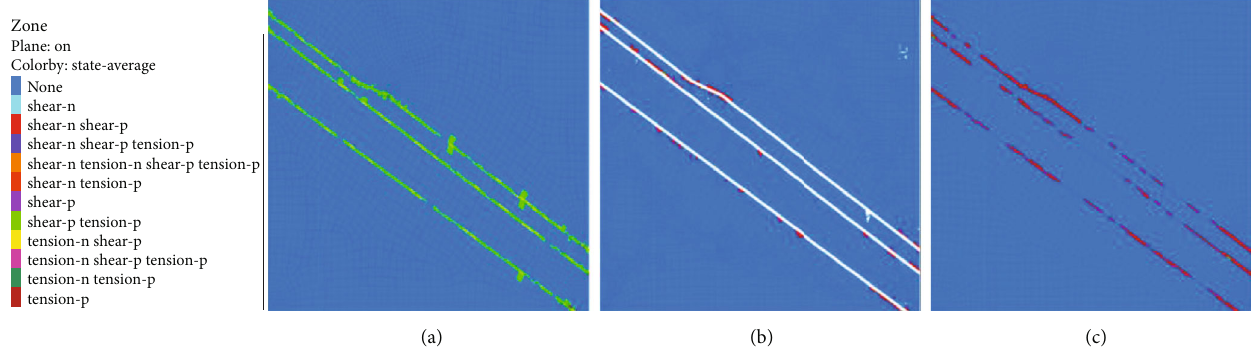
Figure 9: Distribution of plastic zone of roadway in 302 mining area during mining of 97307 working face. (a) Plastic zone of 3# coal roadway roof; (b) plastic zone of two sides of 3# coal roadway; (c) plastic zone of 3# coal roadway fl oor.